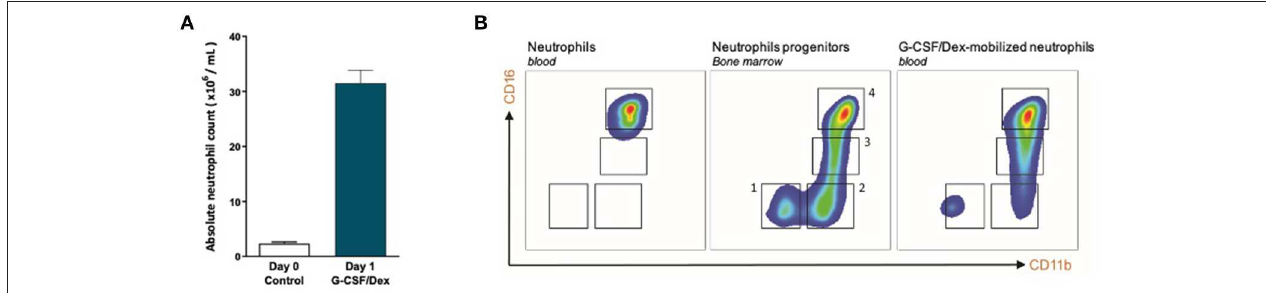
FIGURE 1 | G-CSF/Dex-mobilized donors have an increased amount of neutrophils including immature and mature neutrophils. (A) Absolute neutrophil count of peripheral blood from G-CSF/Dex-treated donors before and after administration n = 5. (B) Surface marker expression of CD11b and CD16 was measured by flow cytometry analysis of neutrophils from blood of healthy donors (left panel), neutrophil progenitors from bone marrow (center panel) and G-CSF/Dex-mobilized neutrophils. The four indicated neutrophil progenitor populations are (pro)myelocytes (1, CD11b NEG CD16 NEG ), metamyelocytes (2, CD11b POS CD16 NEG ), band cells (3, CD11b POS CD16 DIM ) and segmented cells (4, CD11b POS CD16 POS ). Shown are representative FACS analysis images ( n =